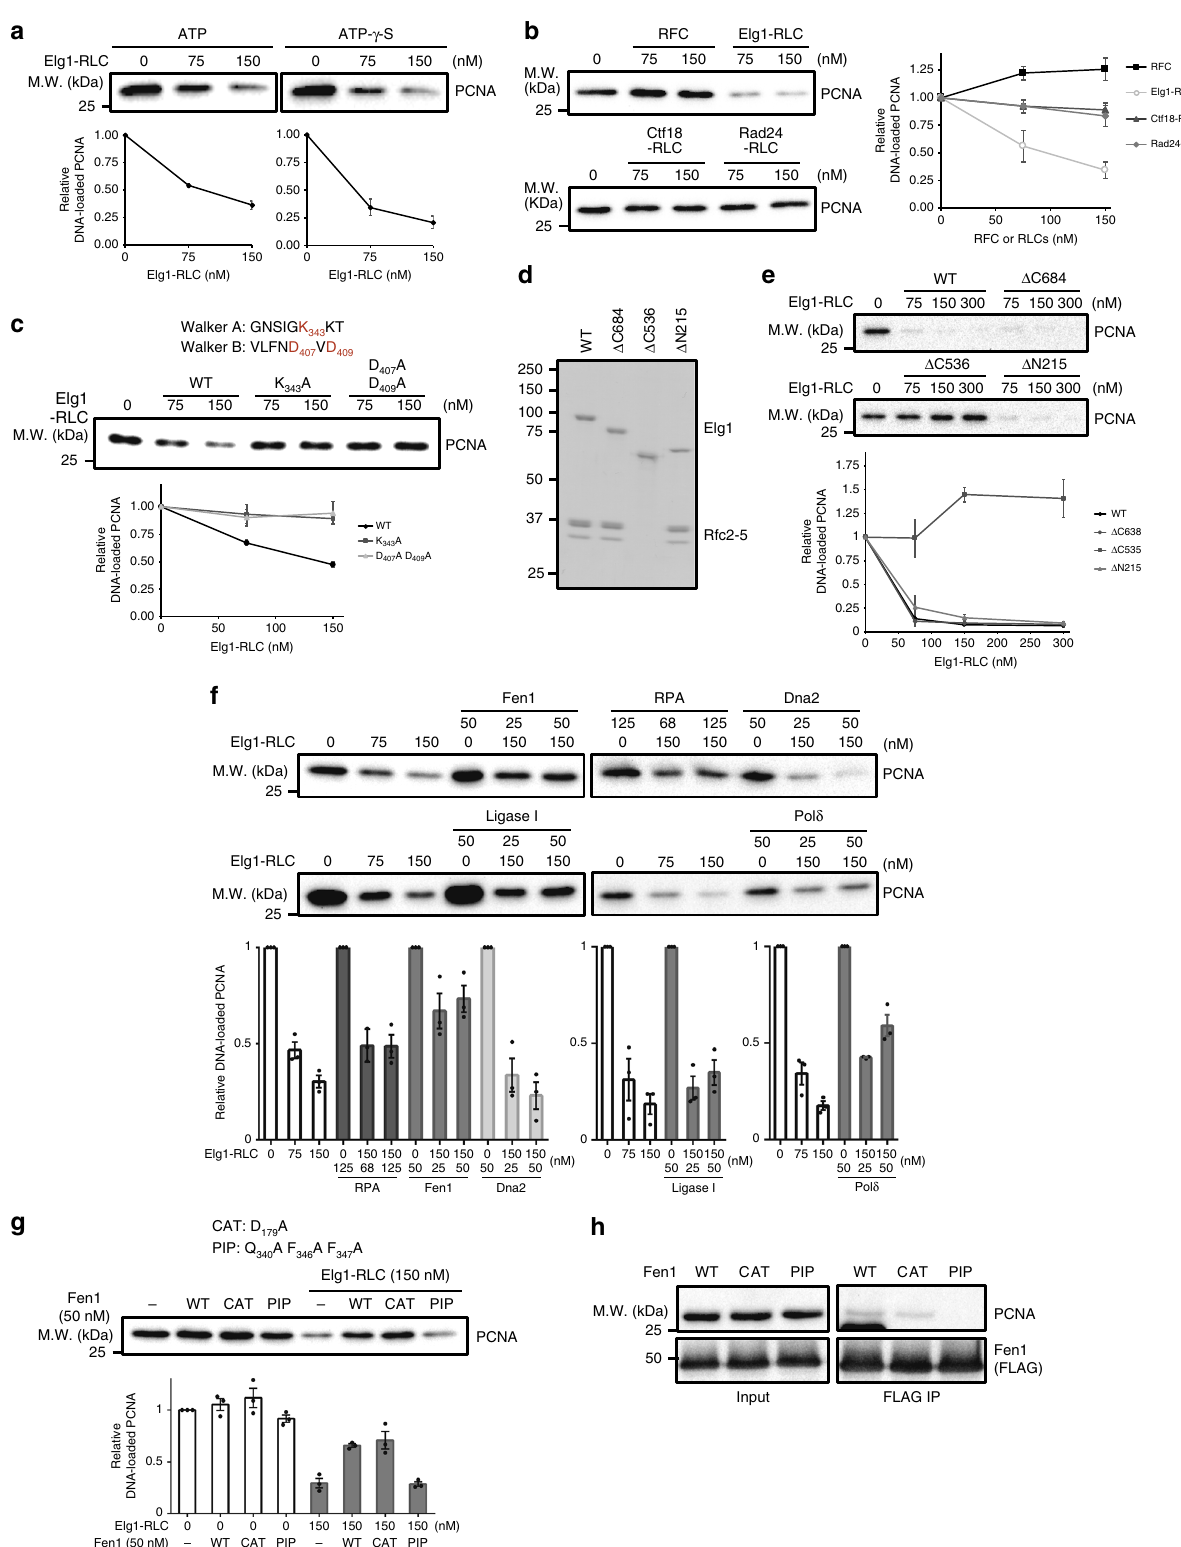
(GNSIGK 343 KT) and Walker B (VLFND 407 VD 409 ) motifs were conserved (Fig. 6c). A mutation in the conserved lysine (K343) in Walker A or mutations of two aspartates (D407 and D409) in Walker B abolished PCNA unloading activity (Fig. 6c and